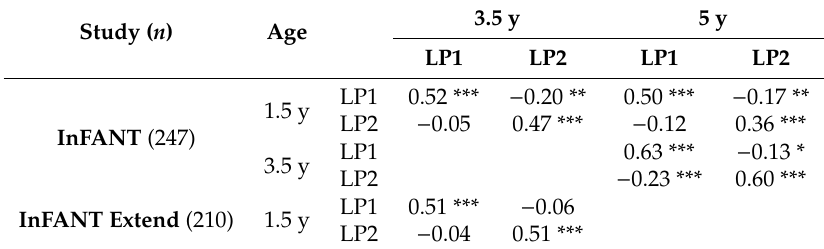
Table 4. Pearson correlation coe ffi cients 1 and p -values between lifestyle patterns (LP) scores identified at 1.5 y, 3.5 y and 5